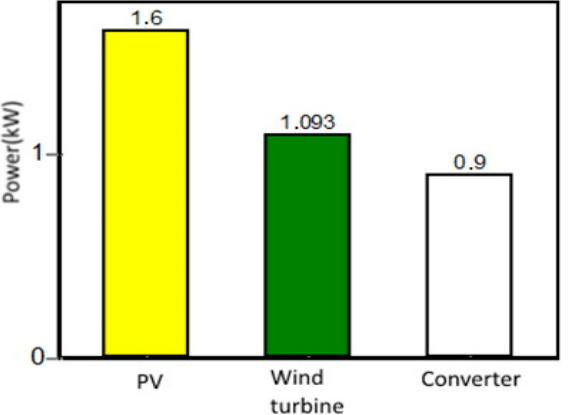
Figure 17. System components of the simulation for the third case using iHOGA.